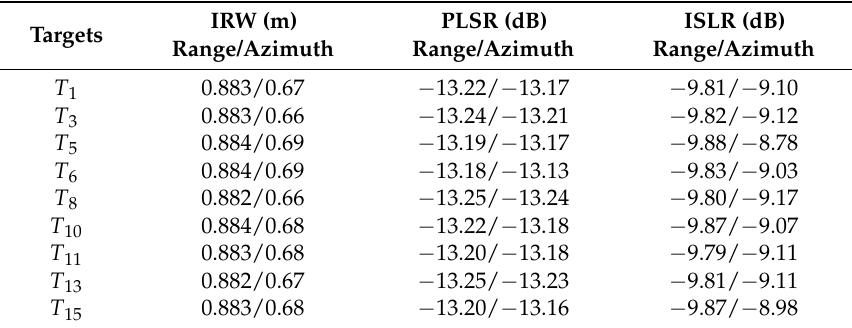
Figure 11. Range and azimuth response of targets near swath edge: ( a ) nearest target; ( b ) farthest target. Table 2. Imaging performance analysis for hypersonic platform SAR. Table 2. Imaging performance analysis for hypersonic platform